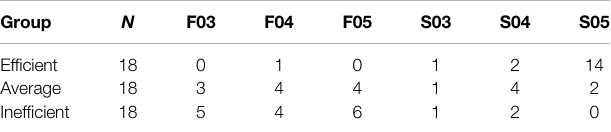
Season is designated as Fall (F) or Spring (S).